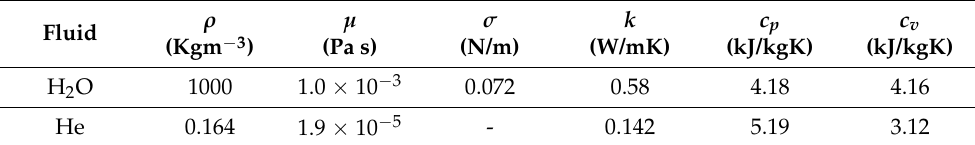
Table 2. Material properties of water and helium at 293 K and 1 bar.